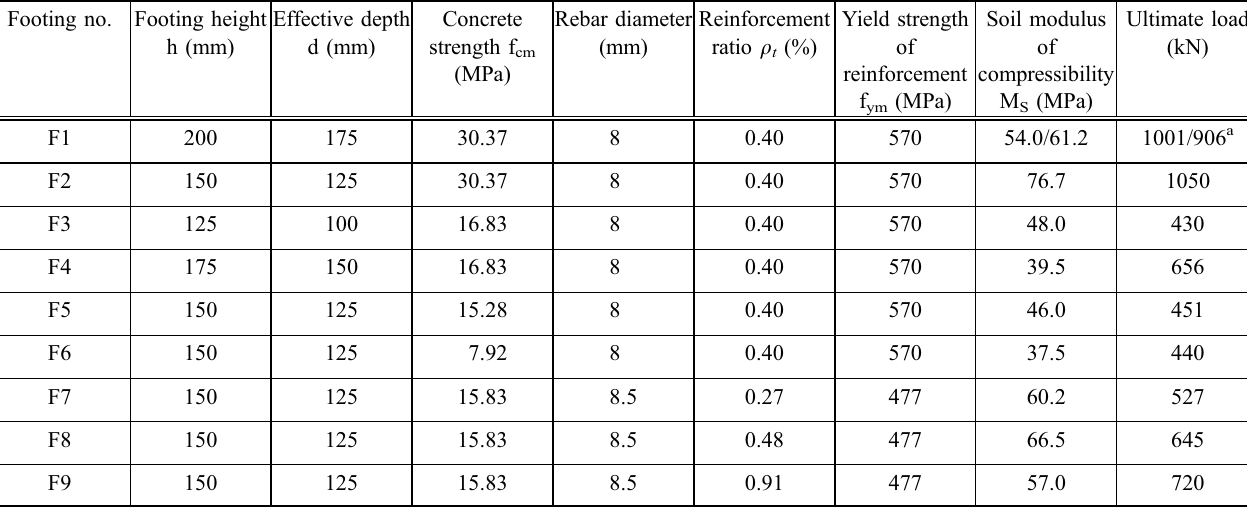
Table 2 Achieved characteristics of test foundations.